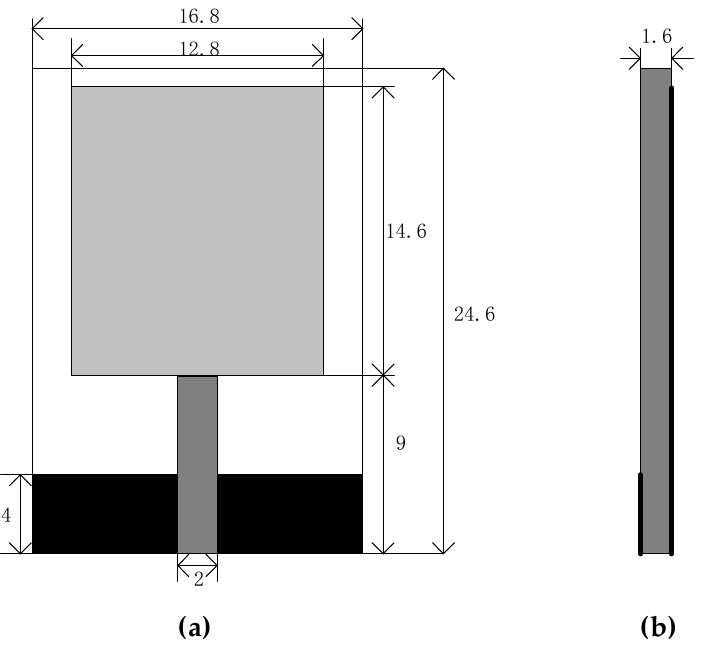
Figure 7. The top view ( a ) and the side view ( b ) of the initial antenna geometry (unit: mm). The initial antenna setting discretized the rectangular patch into 8 × 7 pixels, that is, 56 pixels. The size of each pixel was 2 × 2 mm. To ensure that the two sub patches that were only in contact at the opposite corners could pass the current, each pixel was overlapped at the edge with an overlapping width of 0.2 mm [43]. In the algorithm parameter settings, the population size was set as 10, and the maximum iteration number was set as 30. To ensure that the antenna has enough metal sheets to achieve radiation performance, the curve of the angle modulation function was controlled above the y-axis as much as possible, so the initial range of the parameters d and g was set within [ − 0.5, 1]. The setting range